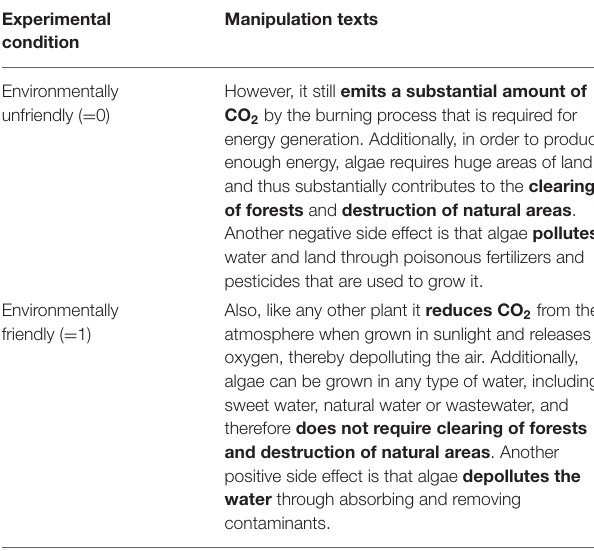
TABLE 6 | Texts containing the experimental